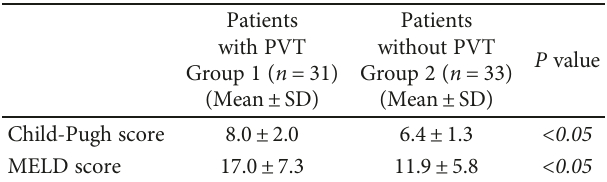
Table 5: Comparison of Child-Pugh and MELD scores in both